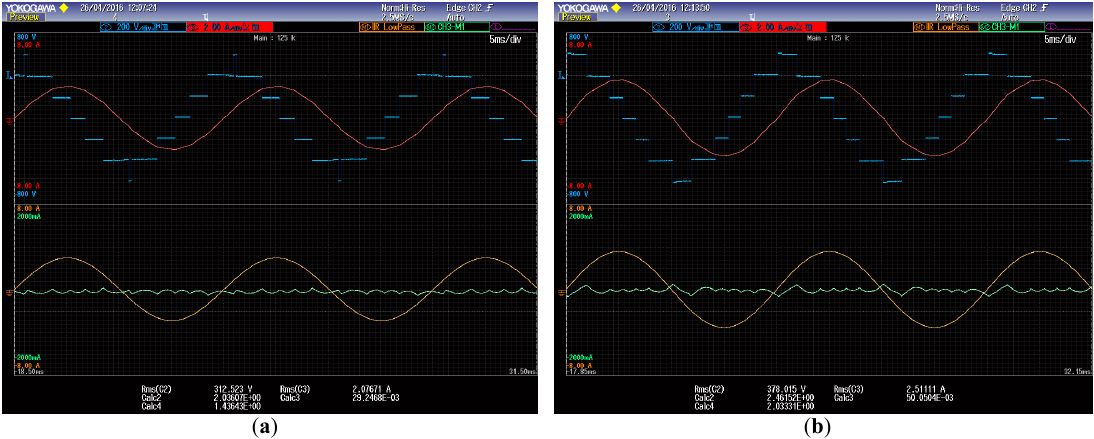
Figure 14. Minimized current THD (Figure 11): ( a ) m = 2.22 ( α 1 = 0.224, α 2 = 0.758, α 3 = 1.527); and ( b ) m = 2.66 ( α 1 = 0.190, α 2 = 0.580, α 3 = 1.294).